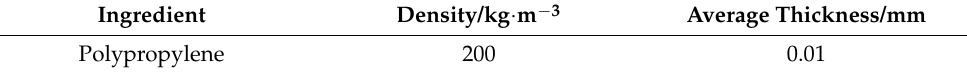
Table 2. Parameters of non-woven fabric.